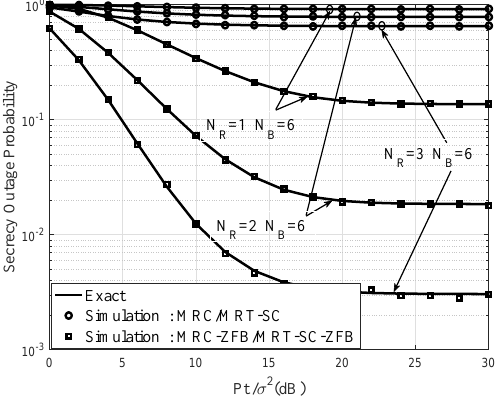
Figure 6. Secrecy outage probability of two schemes for different number N R and fixed N B .